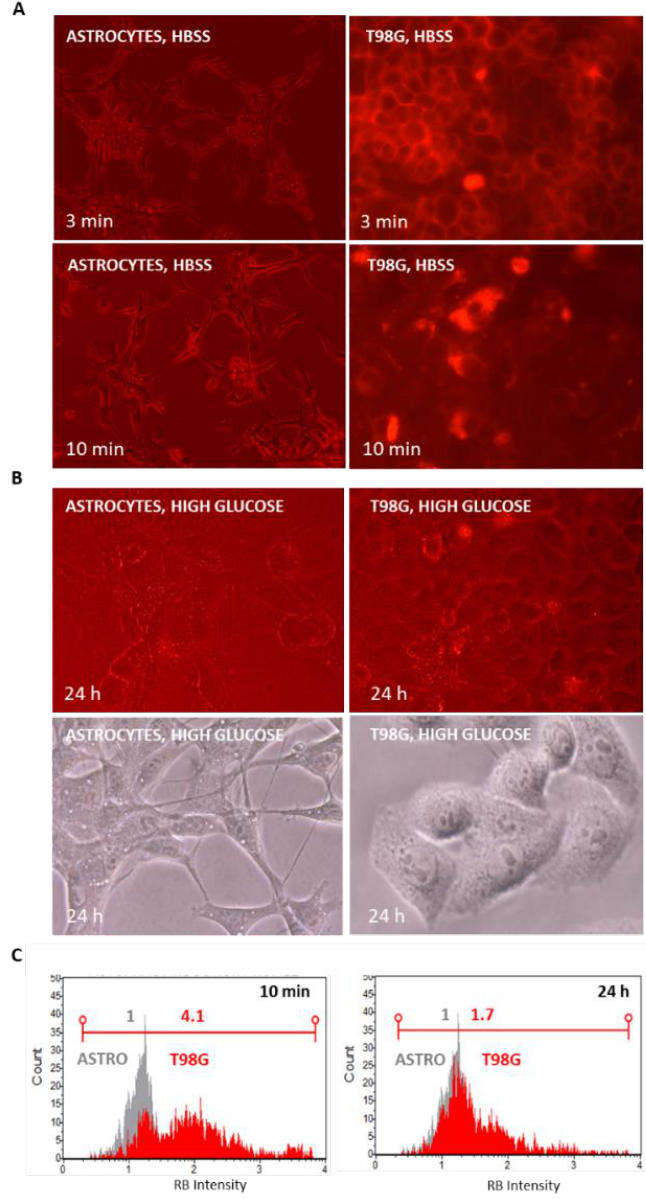
Figure 5. RB intracellular measurements in normal rat astrocytes and T98G cells following amino acids starvation to standard growing conditions. ( A ) Cells were incubated with RB (12.5 µ M) in HBSS media and visualized at 3 and 10 min p.t. using a Nikon Eclipse TS100 inverted fluorescence (20 × ) or optical microscope at 40 × magnification (G2A blocking filter; exc. = 535/50 nm; dichr. mirr. = 577 nm; barrier = 580 nm). ( B ) After reconditioning for 24 h with standard high glucose media, cells were visualized as above under fluorescence and optical microscope. ( C ) In parallel, trypsinized cells ( n = 5000 each) were analyzed in RB intensity using a Guava Muse Cell Analyzer (Luminex, Laser = 532 nm; Filter = 576 ± 14 nm), comparing intensity plots at 10 min vs. 24 h (astrocytes in gray; T98G in red). RB intensity values are normalized to astrocytes RB at 10 min (RB =